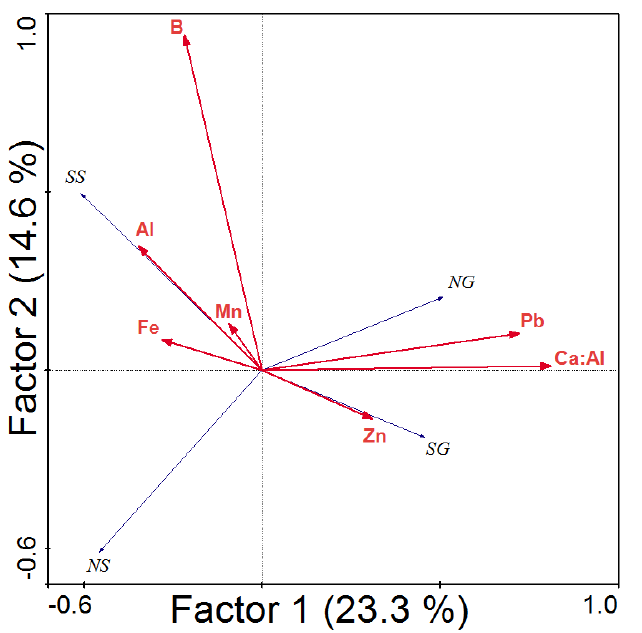
Figure 5. RDA plot showing the relationships between the extractable minor elements in the studied soil profiles.